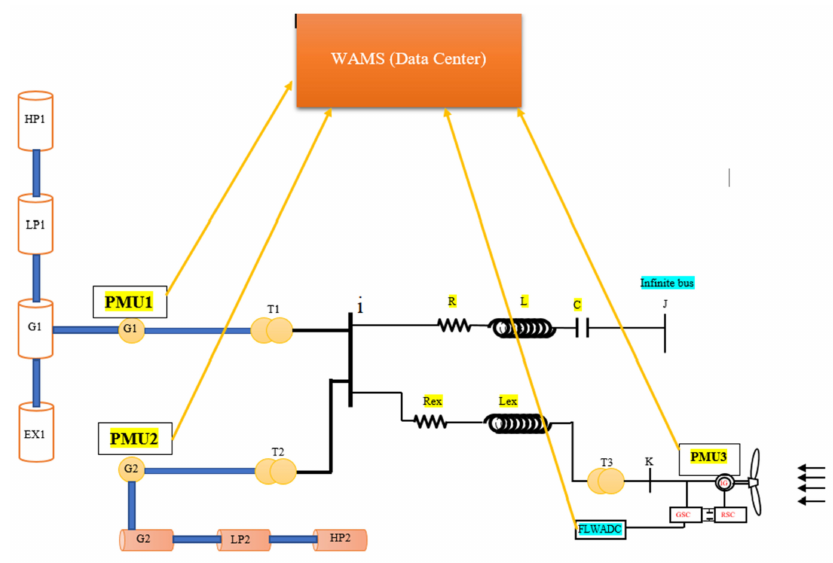
Figure 1. Single-line model of the studied system.